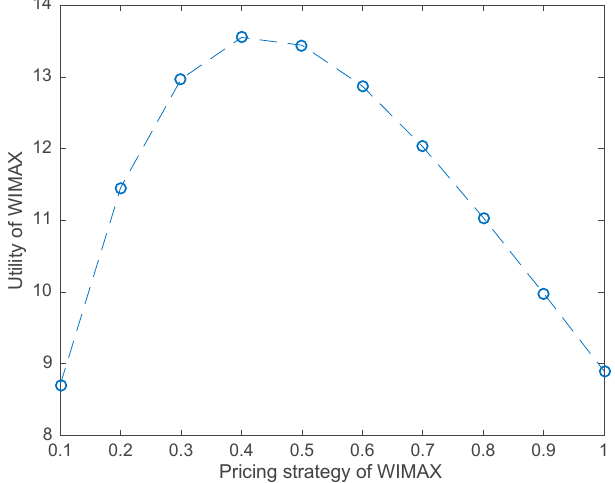
Figure 3. Utility of WIMAX with the bandwidth pricing strategy.